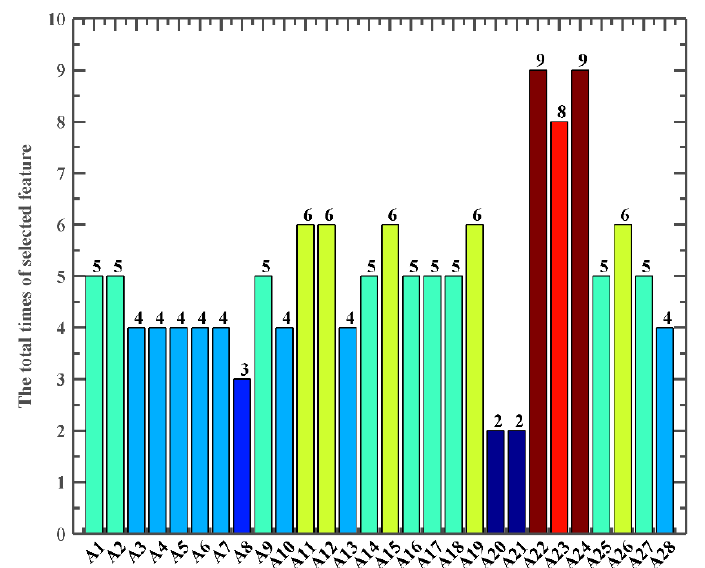
Figure 7. Frequency of the feature selection from RCCBOA-SVM through the 10-fold CV procedure.